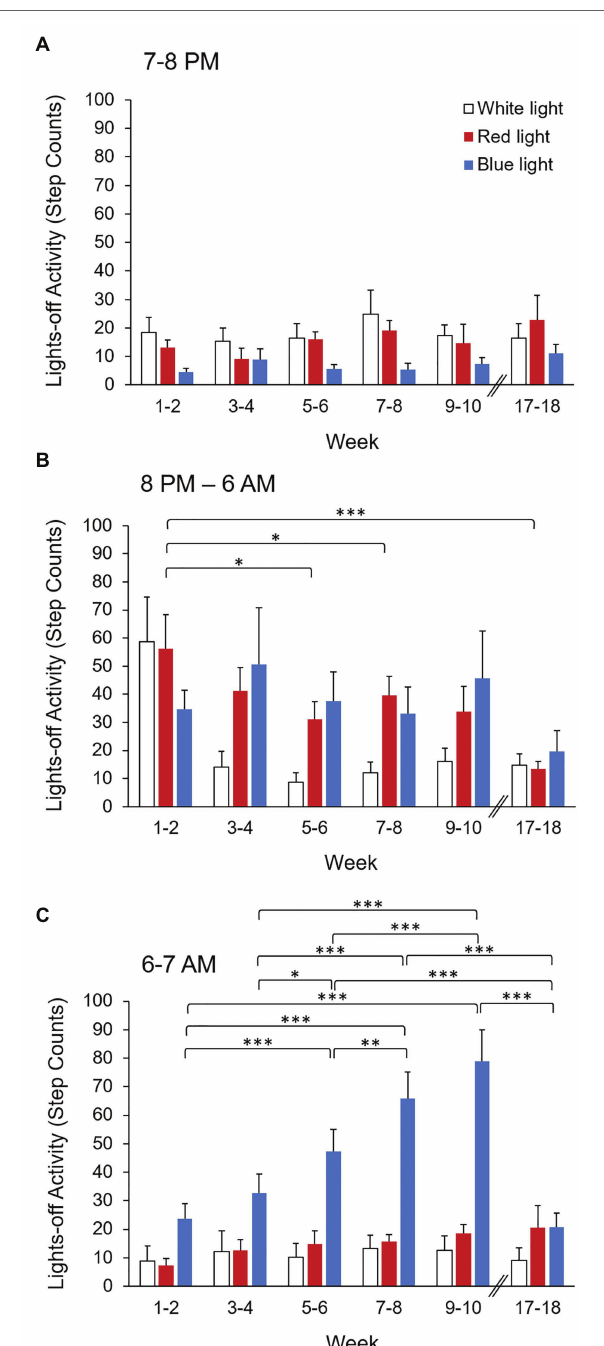
FIGURE 4 | Activity (step counts) during the (A) first hour (7–8 PM), (B) middle 10 h (8 PM–6 AM), and (C) final hour (6–7 AM) of the lights-off period for each 2-week bin for monkeys reared in white light (open bars), red light (red bars), and blue light (blue bars). Error bars represent SEM. * p < 0.05, ** p < 0.01, *** p < 0.001 for pairwise post hoc comparisons between